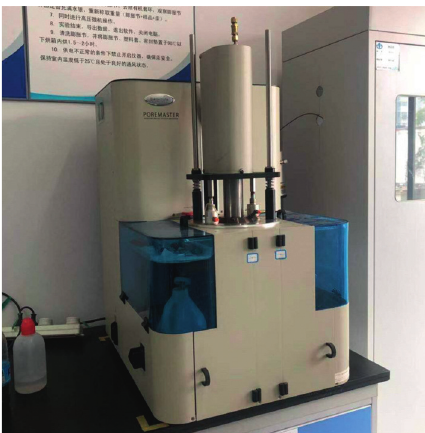
Figure 3: PoreMaster GT-60 Mercury-intrusion apparatus (Quan- tachrome Instruments).